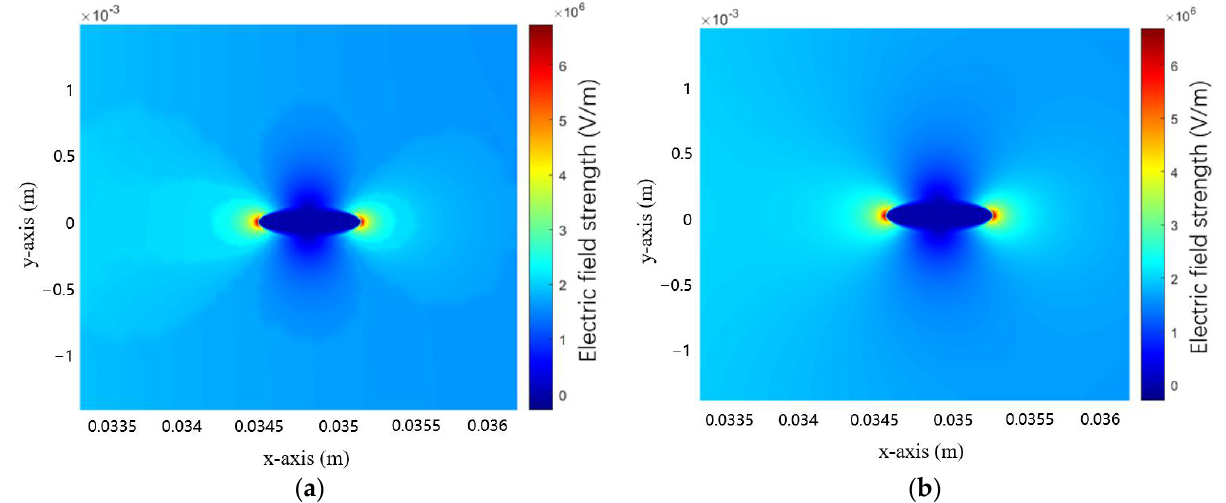
Figure 5. Local enlargement of the calculated values of the data-driven model for changing the impurity conductivity compared with the calculated values of the finite element method, ( a ) Electric field strength at impurities calculated by data-driven model. ( b ) Electric field strength at impurities calculated by finite element.